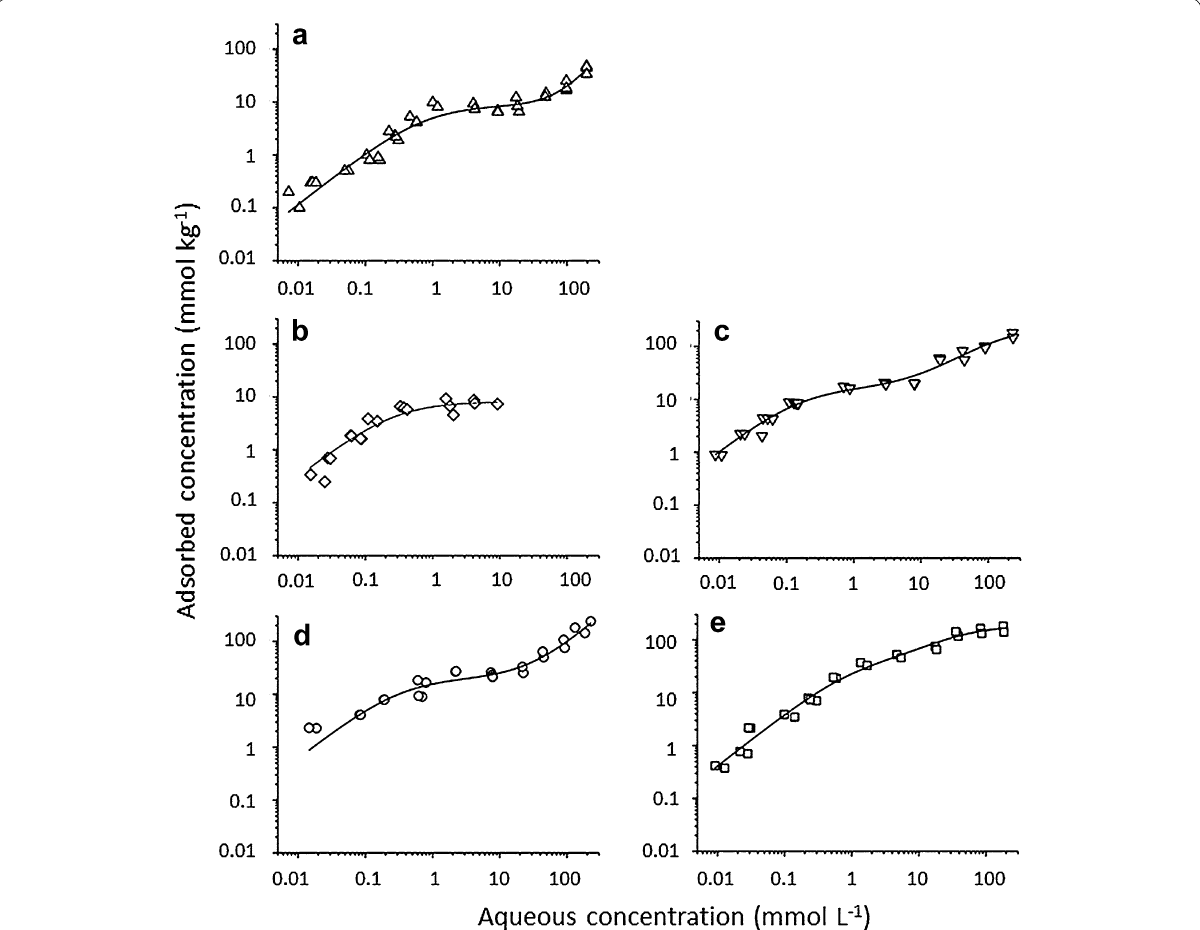
Fig. 4 Sorption isotherms of glycolate ( a ), threonate ( b ), tartrate ( c ), gluconate ( d ), and glucarate ( e ) determined in the gibbsite/ACPW system at pH 13.3. Fitted isotherm functions (lines): glycolate and gluconate: composite Langmuir–Freundlich (parameters: Table 8), threonate: Lang- muir (parameters: Table 7), tartrate and glucarate: two-site Langmuir. The data correspond to equilibrium concentrations. Isotherm parameters for tartrate: X 2 /DOF: 1.39, r 2 : 0.96, K L1 : 6.6 2.2 L mmol − 1 , C sat1 : 16.1 2.7 mmol kg − 1 , K L2 : 0.007 0.002 L mmol − 1 , C sat2 : 228 33 mmol kg − 1 . ± ± ± ± Isotherm parameters for glucarate: X 2 /DOF: 1.66, r 2 : 0.97,